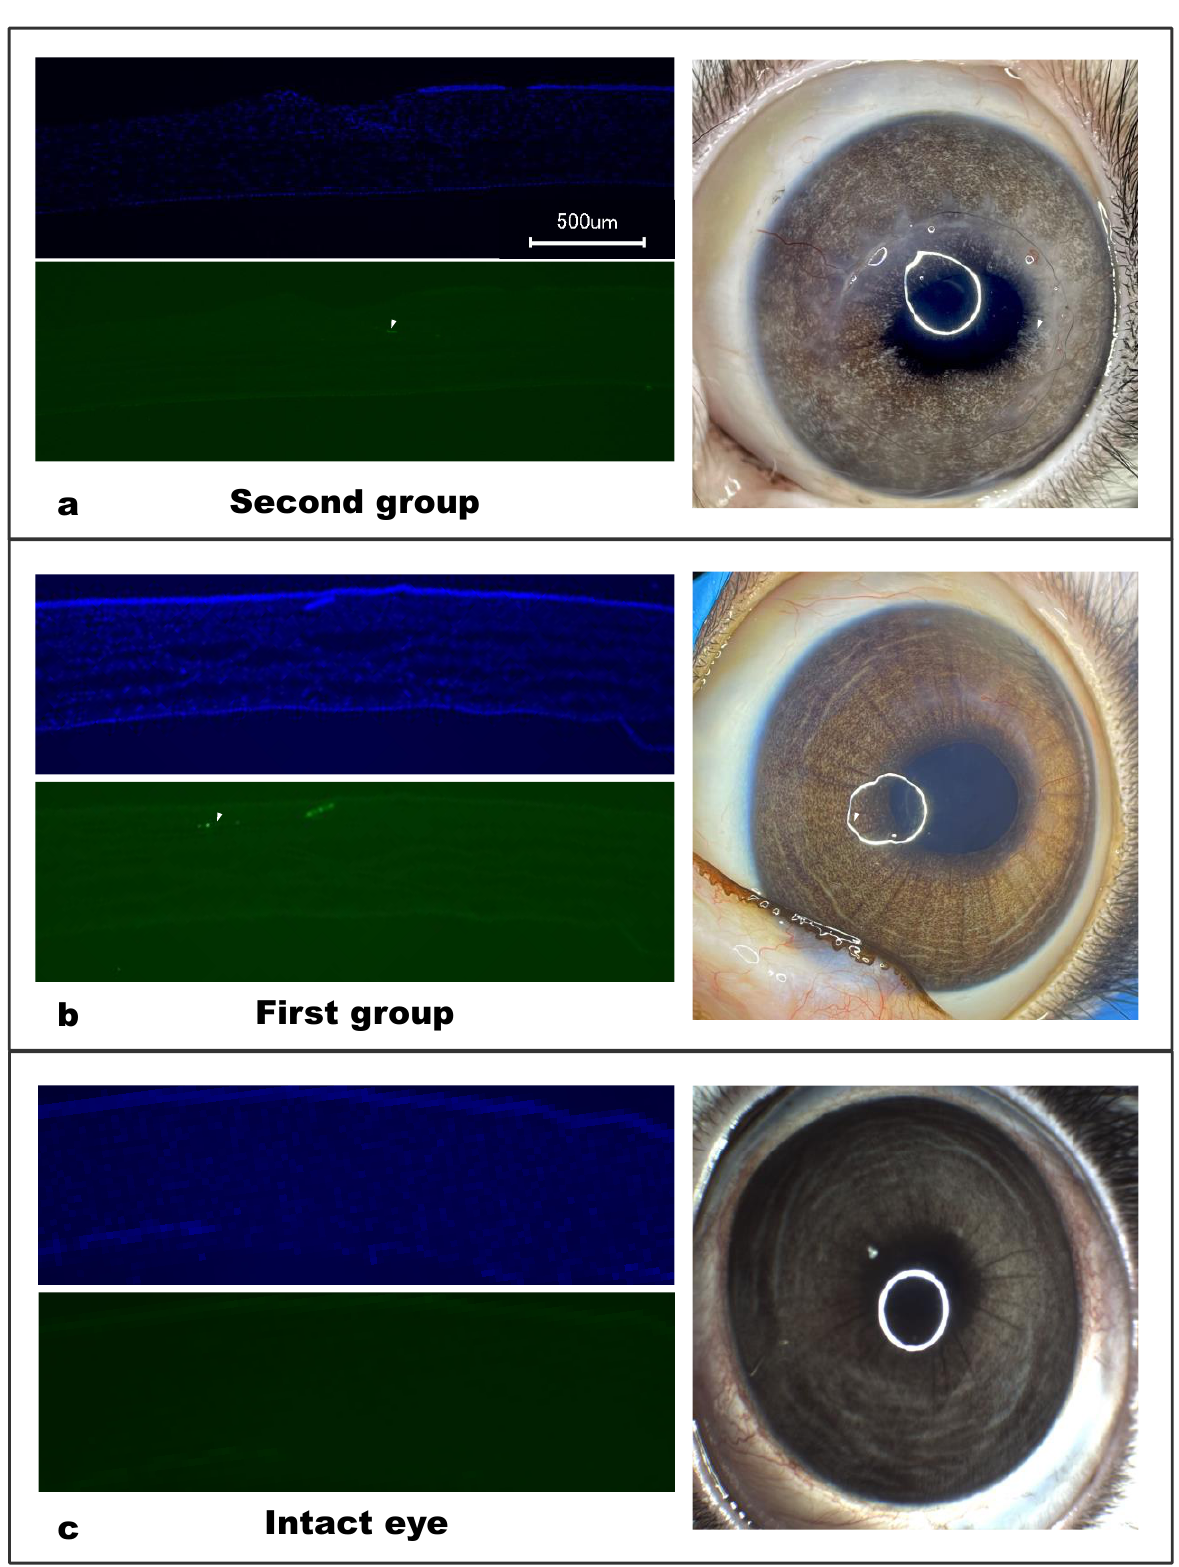
Figure 6. Hematoxylin and eosin staining of a cornea 180 days after the implantation of the collagen membrane: ( a – f ) first group, ( g , h ) intact cornea. Arrows indicate the migration of host cells into the membrane. Scale bar = 100 µm.